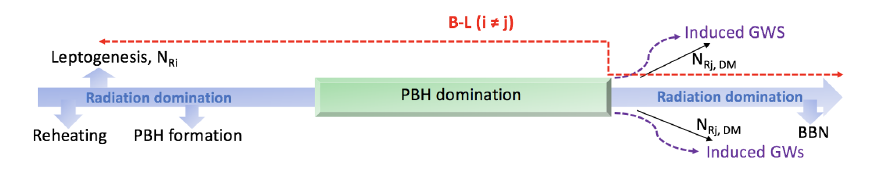
Figure 1 . A possible timeline for the proposed